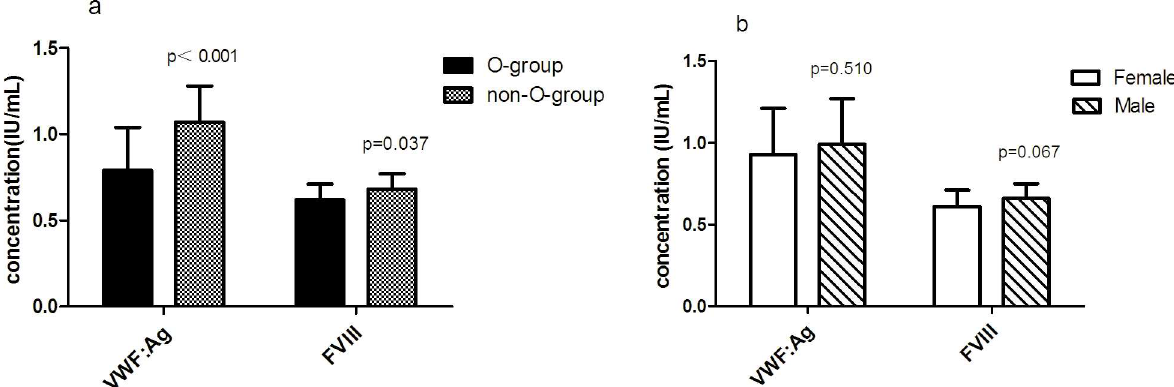
Fig 2. Levels of vWF: Ag and FVIII in HA blood donors with different genders and blood types. Values are mean ± SD. Non-O- group, n = 24; O-group, n = 17; Female, n = 18; male, n = 23.